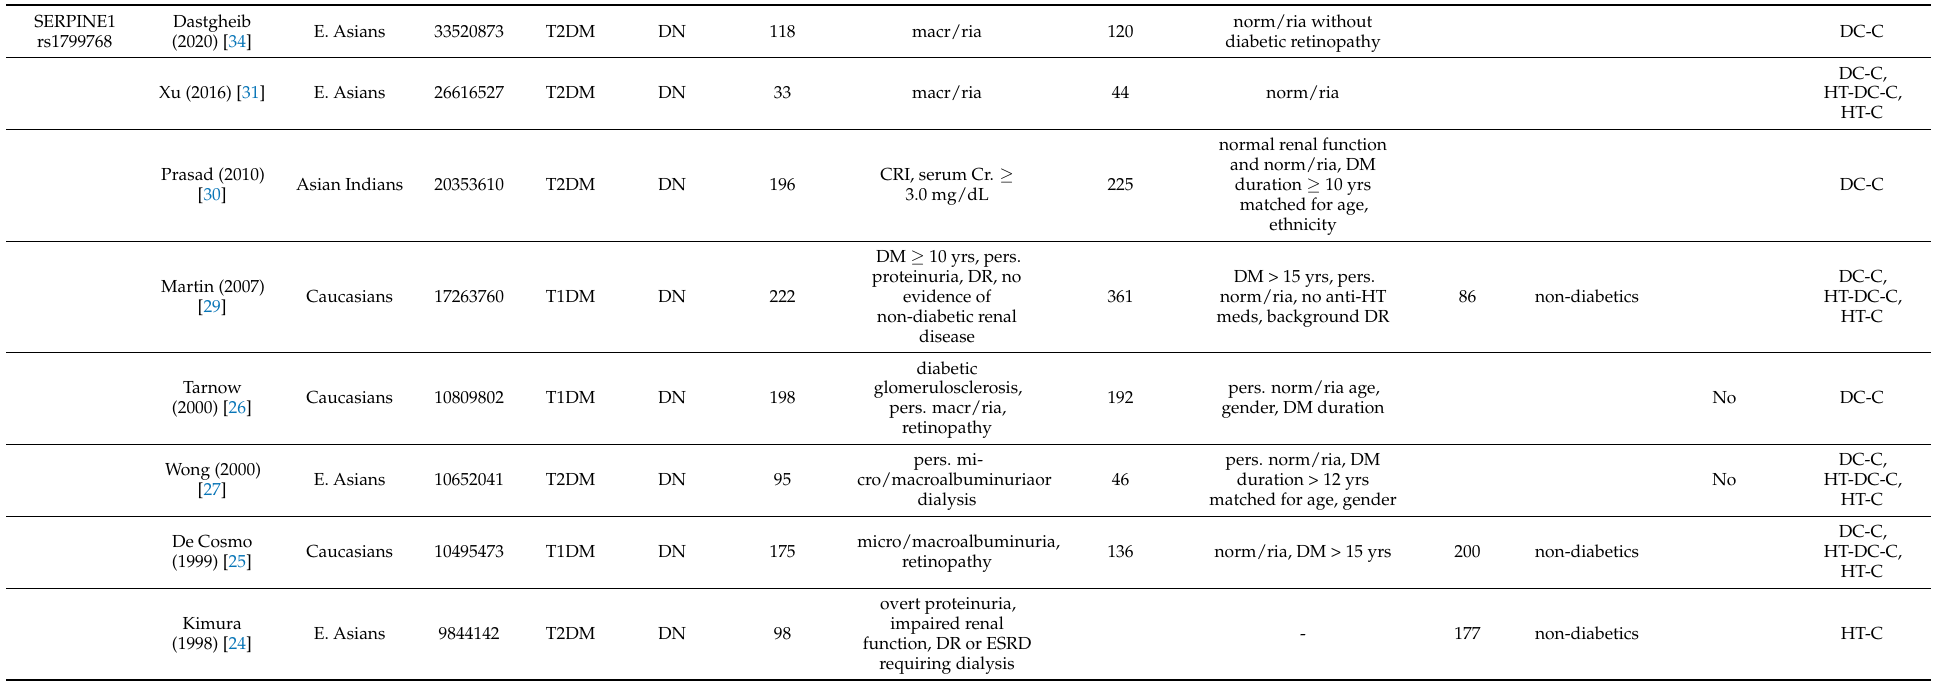
Table 4. Demographic characteristics of the participants of the included studies in the